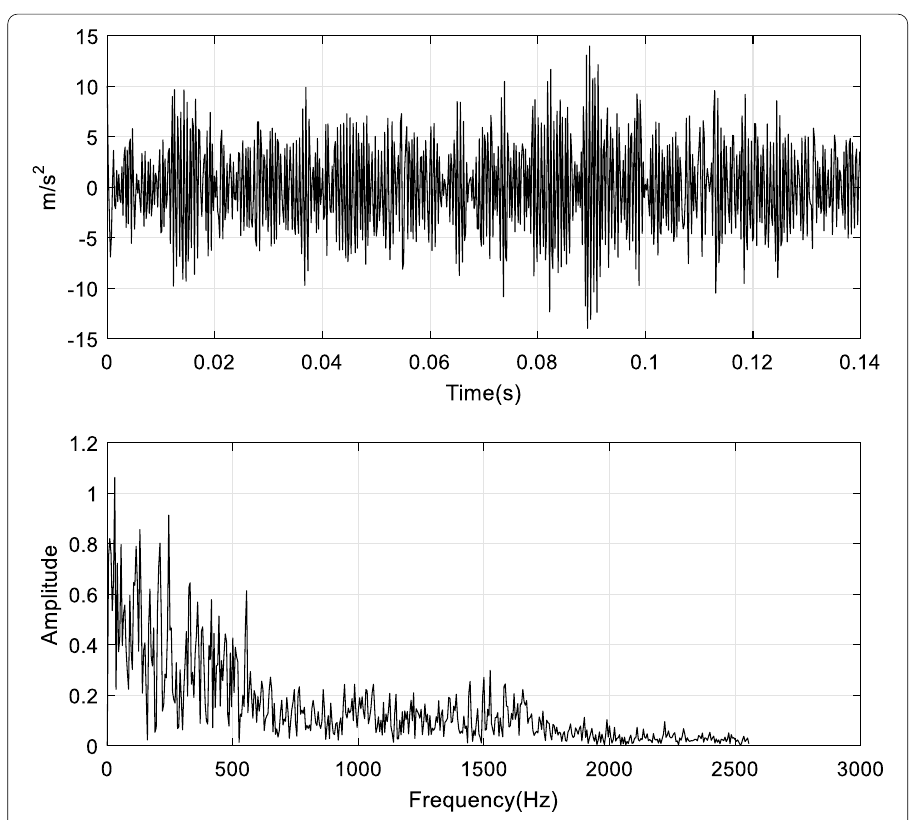
Table 2 Comparison of JTFE and PSK of output signals Methods JTFE PSK Measured signal